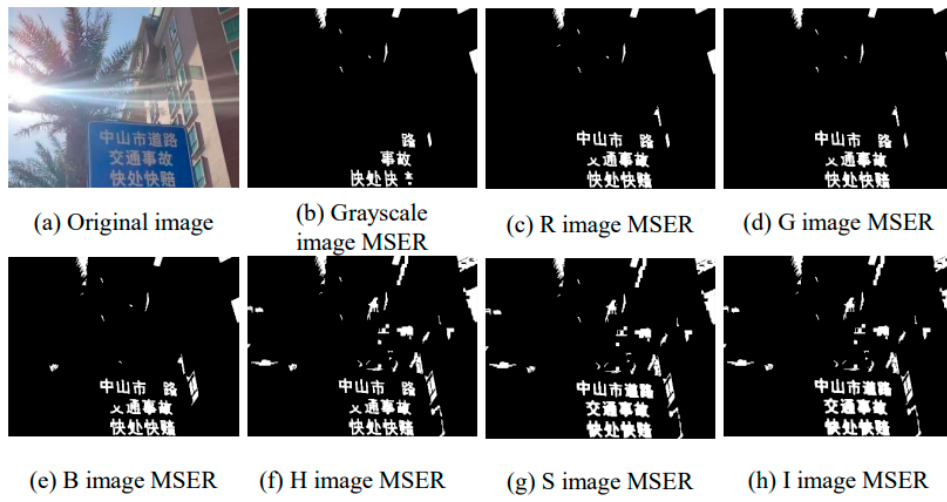
Figure 3. The MSER extraction results of different color channels.